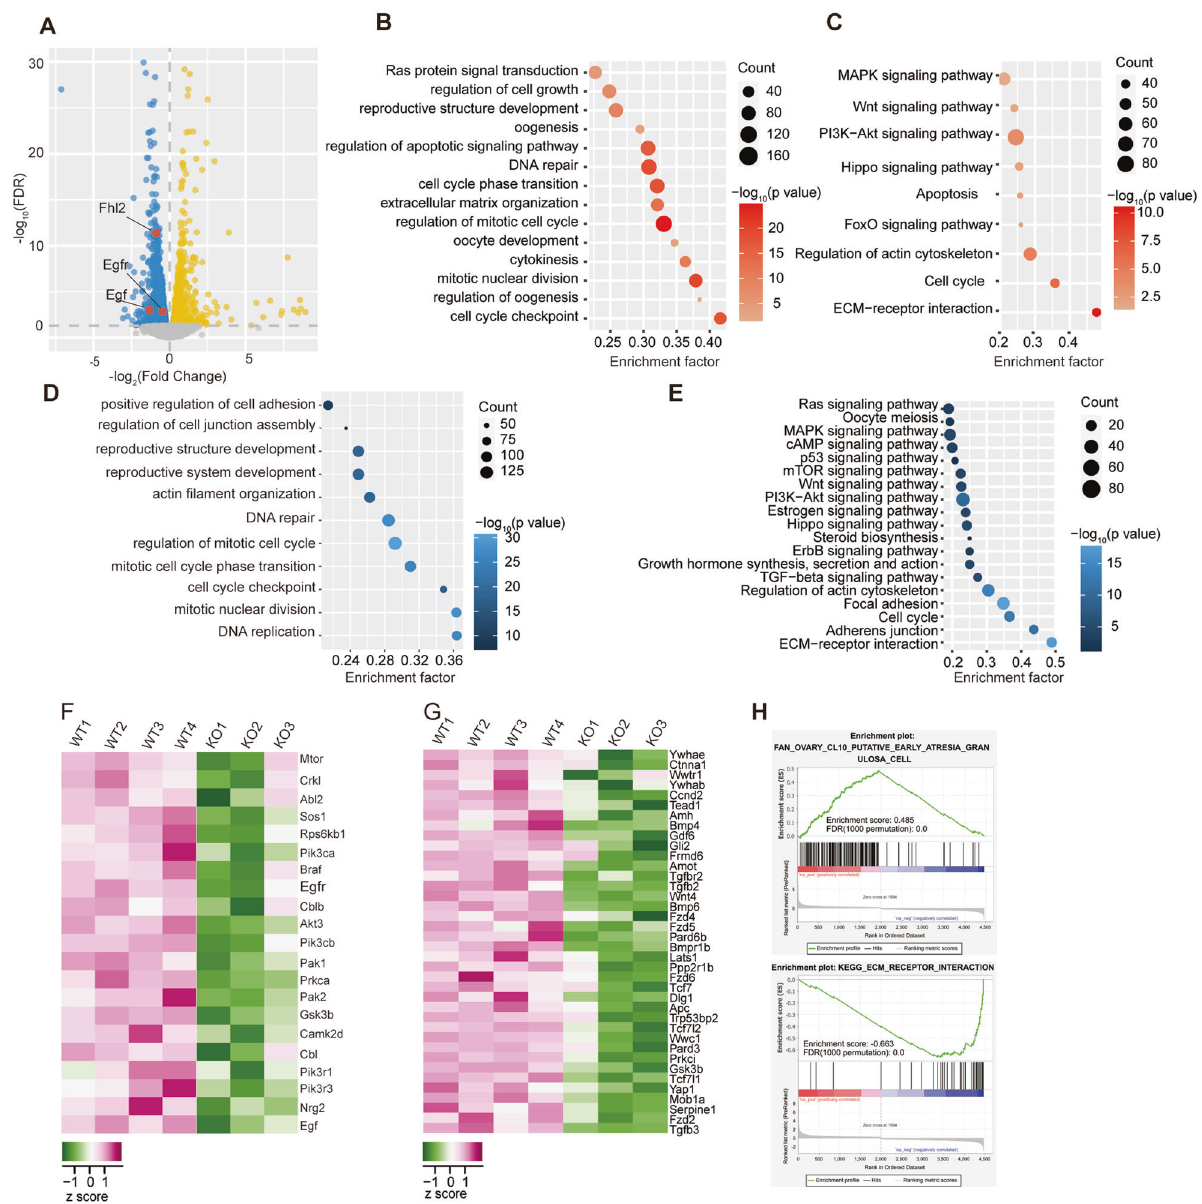
Fig. 2 Bioinformatics analysis of differentially expressed genes in ovarian GCs of 3-week-old WT and Fhl2 KO mice. A Volcano plot showing differentially expressed genes (DEGs) (FDR ≤ 0.05) between WT and Fhl2 KO mice. Yellow and blue dots represent the up-regulated or down-regulated genes in KO mice, respectively. Fhl2 , Egfr and Egf were indicated by red dots. B , C Representative GO and KEGG enrichment results ( P ≤ 0.05) of all DEGs between ovarian GCs of WT and KO mice, respectively. D , E Representative GO and KEGG enrichment results ( P ≤ 0.05) of down-regulated DEGs in Fhl2 KO mice ovarian GCs. F Expression heatmap of DEGs in Erbb signaling pathway. G Expression heatmap of DEGs in Hippo signaling pathway. H Representative Gene Set Enrichment Analysis (GSEA) results (FDR ≤ 0.05) of all DEGs between WT and KO mice ovarian GCs. The FDR is obtained from the P -value based on 1000 times permutation